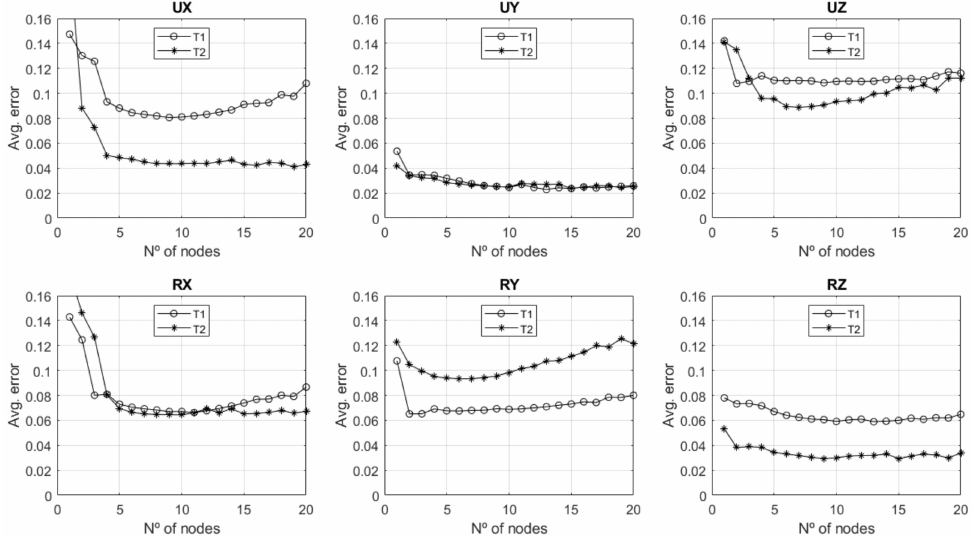
Figure 8. Average errors in comparison to the number of nodes in the ANN (1000 networks).